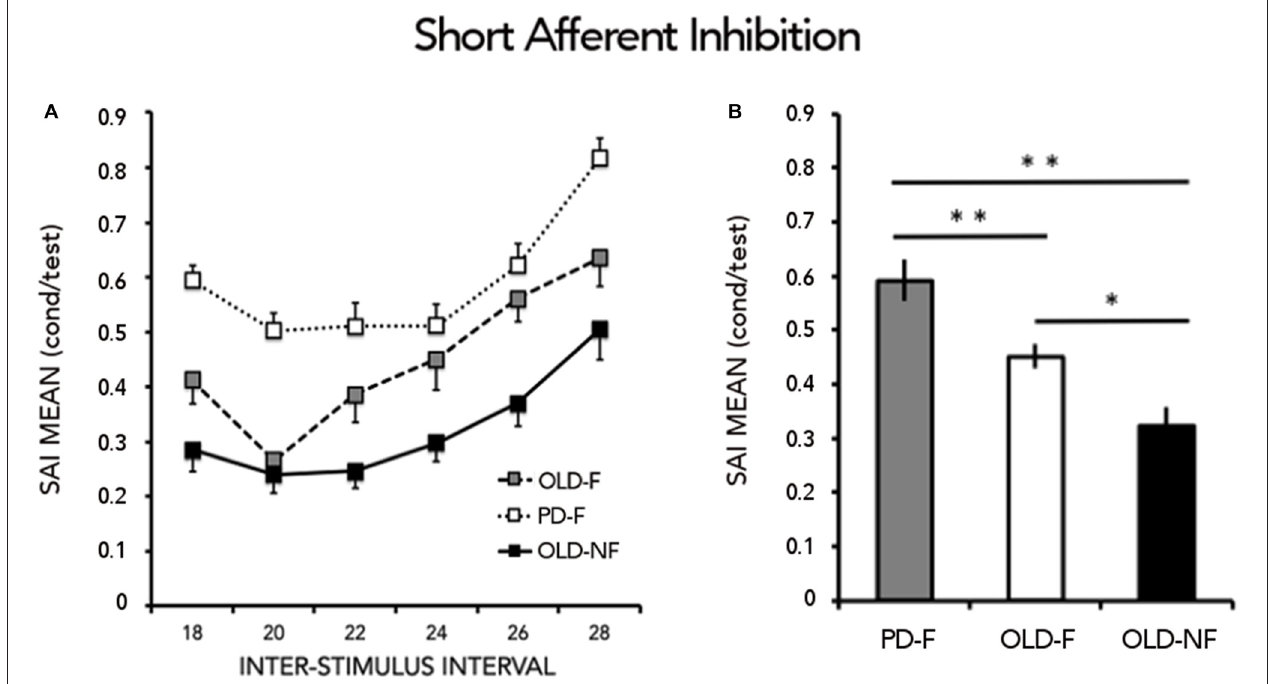
FIGURE 2 | Results from short latency afferent inhibition (SAI). (A) Time course of inhibition. Abscissa indicates the interstimulus intervals (ISIs) whereas ordinate indicates the size of the conditioned response, expressed as a percentage of the unconditioned motor evoked potentials (MEPs). (B) Grand mean of SAI calculated by combining across all interstimulus intervals (ISIs) the conditioned responses and expressed as the percentage of the unconditioned MEPs. Asterisks indicate significant between groups difference ( ∗ p < 0.05, ∗∗ p < 0.01). PD-F, Parkinson’s Disease fallers; OLD-F, Older adults fallers; OLD-NF, Older adults non fallers.